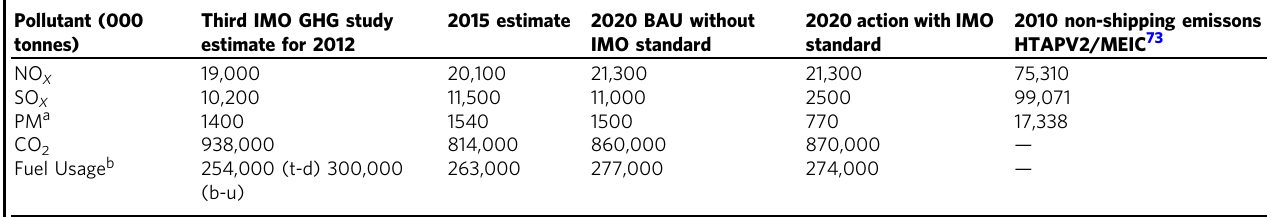
Table 1 Summary of emissions (and fuel consumption) of this work using STEAM for 2020 compared with Third IMO GHG Study (Smith et al. 12 ) and all non-shipping